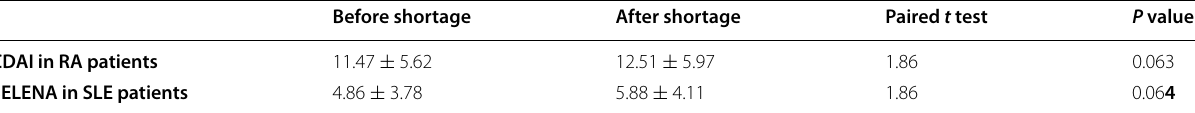
CDAI clinical disease activity index, RA rheumatoid arthritis, SELENA safety of estrogens in systemic lupus erythematosus national assessment, SLE systemic lupus erythematosus *Significant P value if p < 0.05